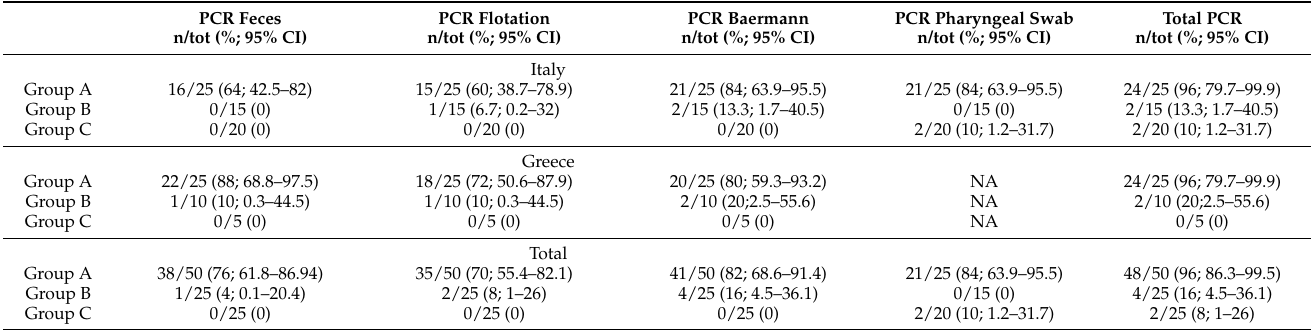
Table 3. Overall positivity in a nested PCR species-specific for Aelurostrongylus abstrusus of different fecal aliquots and pharyngeal swab collected from cats of the present